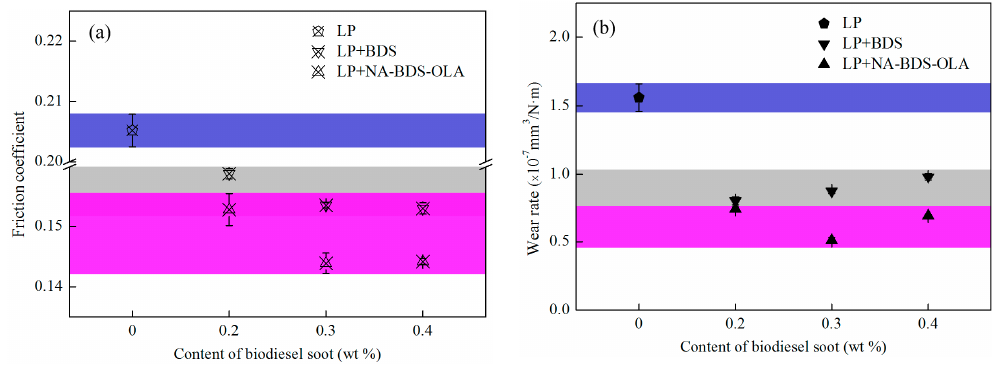
Figure 9. Evolutions of the ( a ) average friction coefficient and ( b ) wear rates for lubrication with different amounts of BDS and NA-BDS-OLA in LP (load = 100 N, speed = 50 mm/s, duration = 30 min).